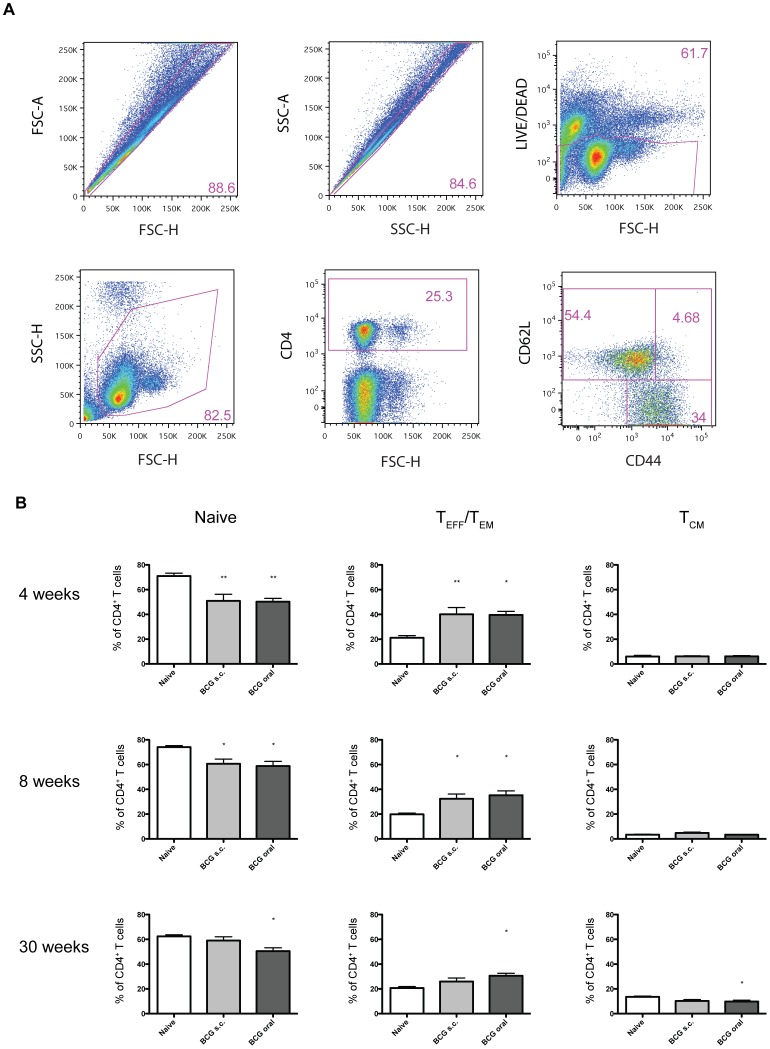
Oral vaccination with Liporale™-BCG induces long-lived CD4+ effector T cells in the lung.Lymphocytes from the lungs of naïve, Liporale™-BCG vaccinated (BCG oral) or subcutaneous vaccinated (BCG s.c.) mice were analyzed by flow cytometry. (A) Representative flow cytometry plots show the gating strategy used to identify CD4+ T cells. (B) Bar graphs show the proportion of naïve (CD62Lhi, CD44lo), TEFF/TEM (CD62Llo, CD44hi) or TCM (CD62Lhi, CD44hi) CD4+ T lymphocytes of total CD4+ T cells from the lungs of naïve or BCG vaccinated mice at 4, 8 and 30 weeks post vaccination. Results are displayed as mean + SEM of n = 5 for each group, significance expressed relative to naïve: *p<0.05, **p<0.01, ***p<0.001 (one way ANOVA with Tukey post test). Eight and 30 weeks results are representative of 2 independent experiments.